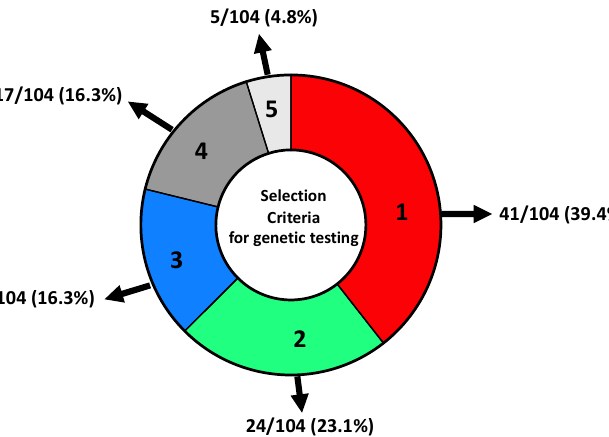
Figure 2. Distribution of patients selected for NGS genetic testing concerning inclusion criteria. (1) Women with BC and OC; males with BC; women with triple-negative breast cancer (TNBC) < 60 years; women with BC < 36 years; women with bilateral BC < 50 years; not mucinous and not borderline OC at any age; metastatic pancreatic adenocarcinoma; metastatic prostatic carcinoma. (2) Personal history of breast cancer diagnosed < 50 years and at least one first-degree relative with nonmucinous and nonborderline OC at any age; BC < 50 years; male BC; bilateral BC; metastatic pancreatic adenocarcinoma and metastatic prostatic carcinoma. (3) Personal history of BC > 50 years and family history of breast, ovarian cancer, metastatic prostatic carcinoma and metastatic pancreatic adenocarcinoma in 2 or more first-degree relatives (one of which in the first degree with the proband). (4) Presence of personal and family history that did not meet AIOM criteria. (5) Patients that were not affected by tumours described by AIOM criteria.